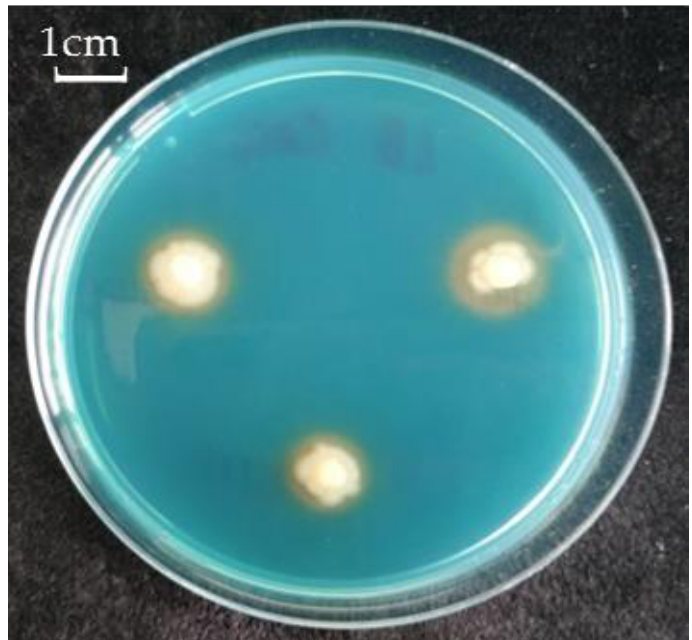
Figure 1. Siderophore production of Pseudomonas sp. OBA 2.4.1. The bar in the photograph indicates 1 cm.